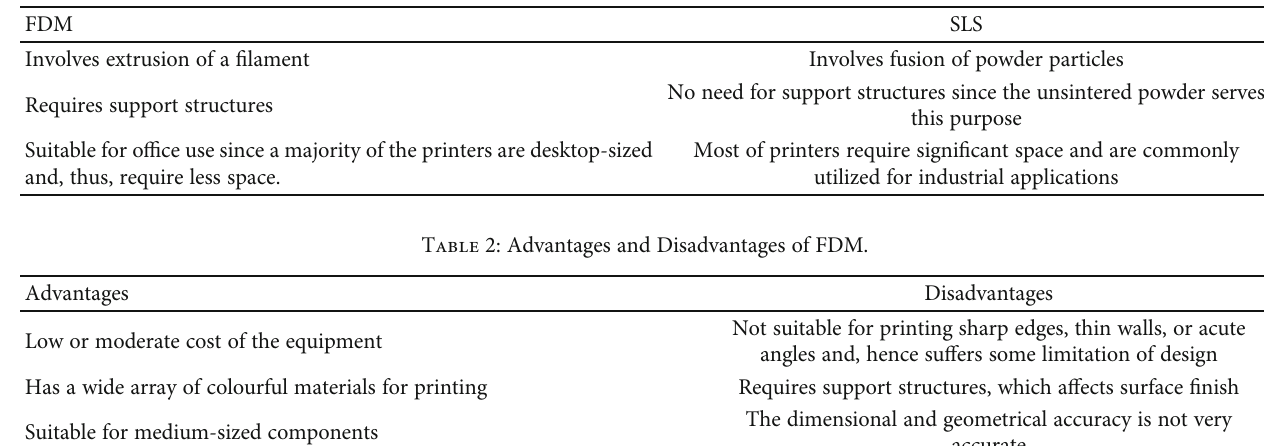
Table 1: A comparison between FDM and SLS AM technologies.